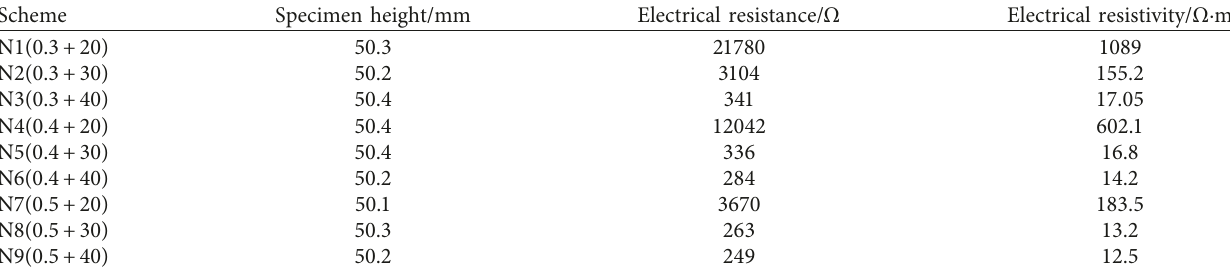
Figure 7: The simulated deicing test. Table 6: Resistance test results of rutting plate